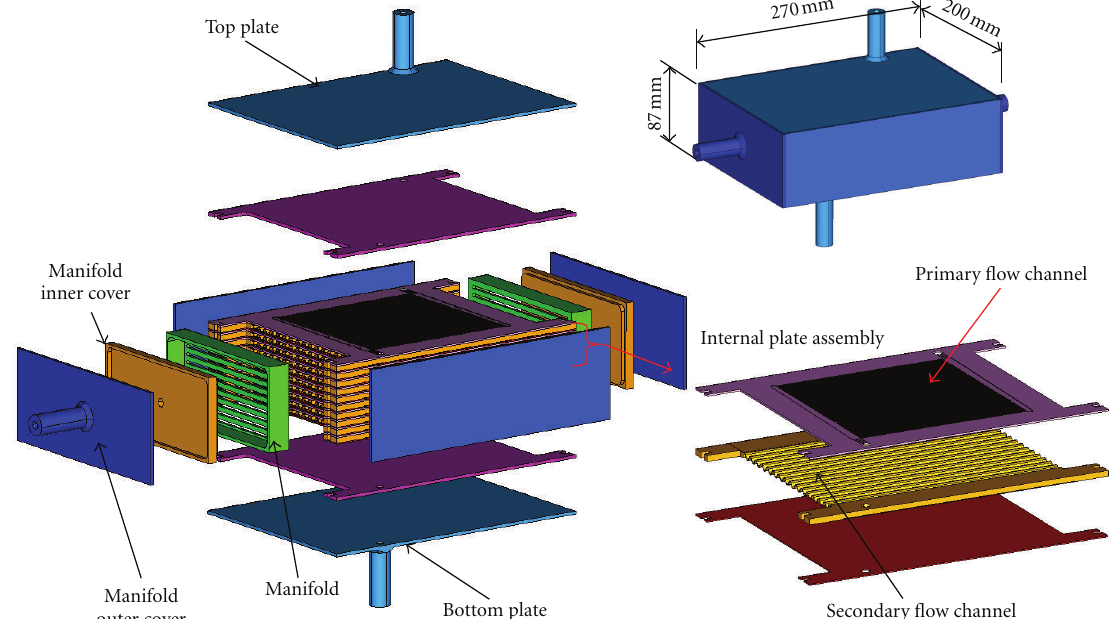
Figure 6: Parts of the PHE